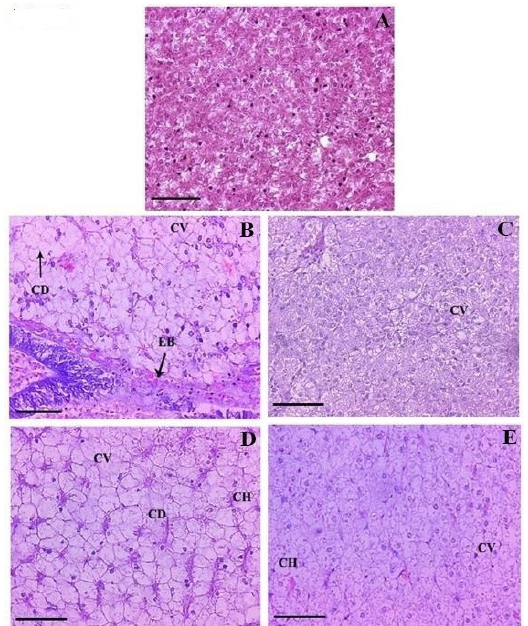
Figure 6. ( A ) Histological features of the livers of control-fed Oreochromis niloticus juveniles showing normal tissue architecture, × 200 H&E staining. Histopathological changes in the livers of florfenicol (FFC)-dosed O. niloticus juveniles at 15 mg kg biomass − 1 day − 1 (1 × group) for 10 consecutive days ( B ) on day 10 of FFC dosing showing marked glycogen-type vacuolation, cytoplasmic degeneration (CD), cytoplasmic vacuolation (CV), and eosinophilic bodies (EB), ×200 H&E staining; and ( C ) on day 21 post-FFC-dosing showing mild glycogen-type vacuolation and cytoplasmic vacuolation (CV), ×200 H&E staining. Histopathological changes in the livers of FFC-dosed O. niloticus juveniles at 45 mg kg biomass − 1 day − 1 (3× group) for 10 consecutive days ( D ) on day 10 of FFC dosing showing marked glycogen-type vacuolation, cytoplasmic degeneration (CD), cytoplasmic vacuolation (CV), and cellular hypertrophy (CH), ×200 H&E staining; and ( E ) on day 21 post-FFC dosing showing marked glycogen-type vacuolation, cytoplasmic vacuolation (CV), and cellular hypertrophy (CH), ×200 H&E staining. Table 4. Qualitative assessment of major histopathological changes in the kidney and liver tissues of florfenicol-dosed Nile tilapia Oreochromis niloticus juveniles at 0–3 times the therapeutic dose of 15 mg kg biomass − 1 day − 1 for 10 consecutive days on a 5-point ordinal scale * in comparison with the normal architecture.